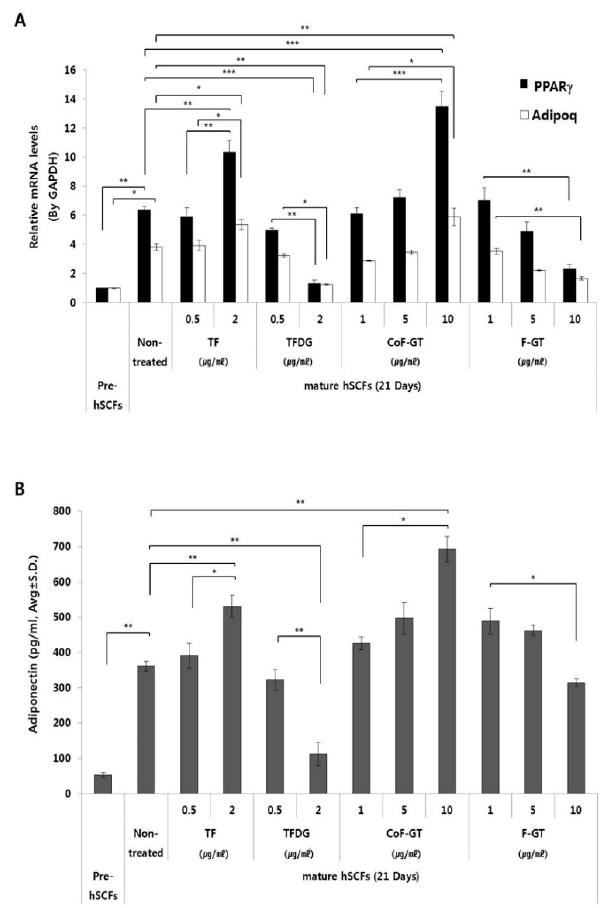
Figure 4. Changes in the expression of adipogenesis-related genes and quantitative analysis of adiponectin release into culture medium. ( A ) After 21 days of hSCF di ff erentiation, peroxisome proliferator activated receptor gamma (PPAR γ ) and adiponectin (ADIPOQ) mRNA expression levels were evaluated by real-time quantitative polyperase chain reaction (RT-qPCR); ( B ) Adiponectin concentration in cell culture supernatant after 21 days of di ff erentiation was measured by enzyme linked immunosorbent assays (ELISA). Data are presented as mean ± SD. * p < 0.05, ** p < 0.01, *** p <